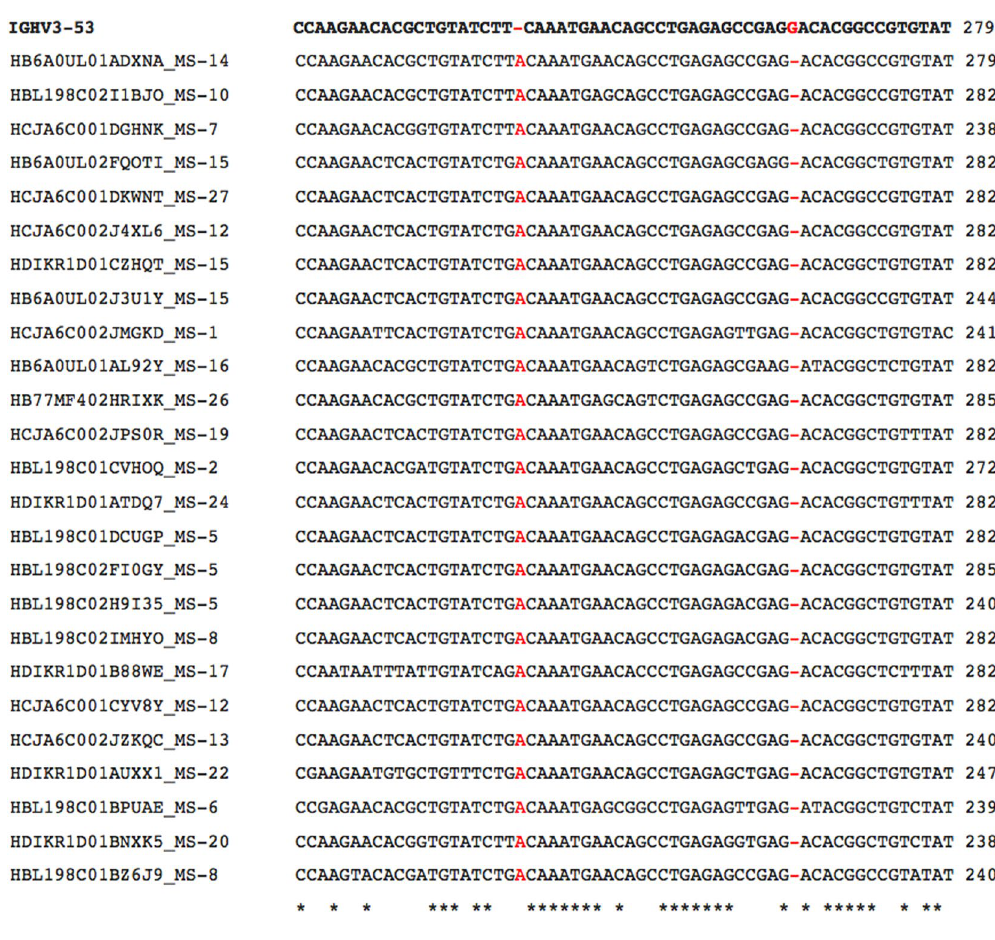
Figure 5. A subset of Prime Motif matching nucleotides have been aligned to the IGHV3-53 germline sequence. The visualized segment of the resulting multiple alignment corresponds with the FR3 region of the antibody sequence. All other lines contain subsequences obtained from Prime Motif matching antibodies. Insertions and deletions in the multiple alignment are highlighted in red. A single adenine insertion is present in all sequences within the input nucleotide subset. The insertion is followed by a single deletion that occurs within the space of 24